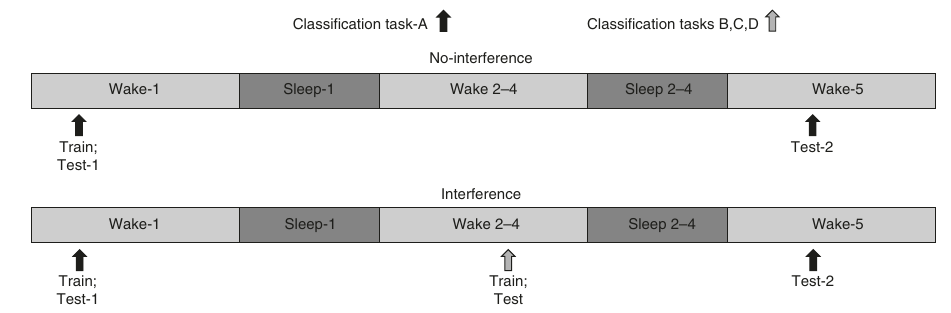
Fig. 8 Experimental design for experiment-4. Thirty starlings were trained to classify 5 s segments of novel starling song. Starlings were trained on